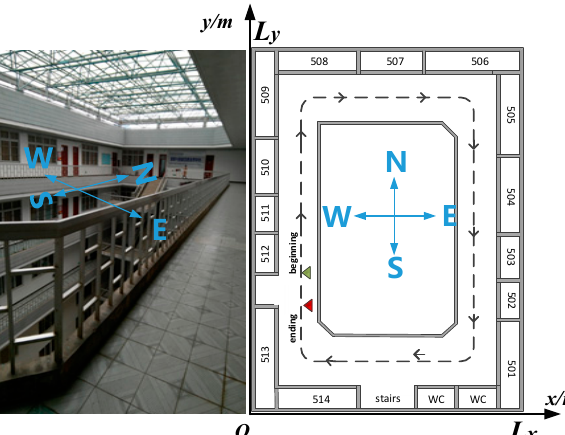
Figure 3. Illustration of the fifth corridor of the Jinji Campus Library in GUET. GUET: Guilin University of Electronic Technology. The dashed lines are the reference walking lines. A small green triangle dot denotes the beginning point and a red one denotes the ending point. The dominant directions are denoted as E: East, S: South, W: West, N: North.